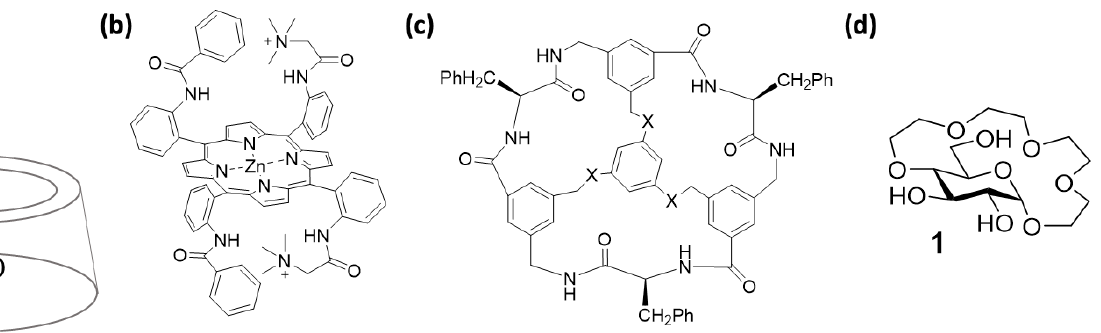
Figure 1. Examples of enantioselective receptors of amino acids based on: ( a ) cyclodextrins [19], ( b ) porphyrins [21], ( c ) and cyclophanes [22]. ( d ) Glucose-based receptor 1 for enantioselective binding of amino acid methyl esters in water [23].